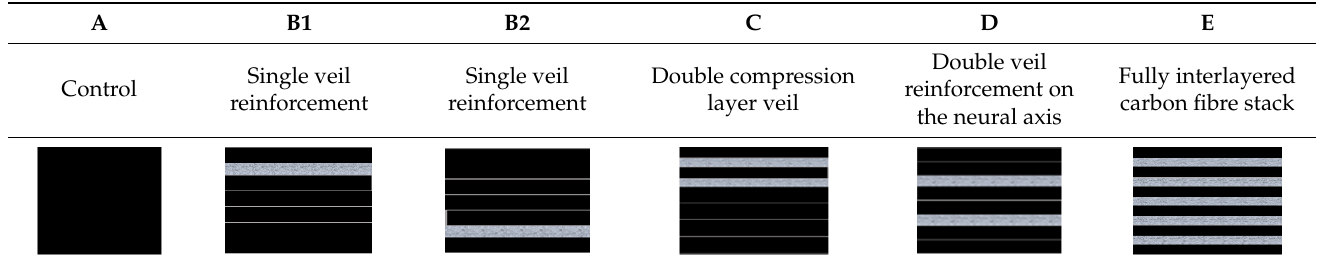
Table 3. Interlayering of carbon fibre stacks with nanofibrous polyamide 6,6 veils.